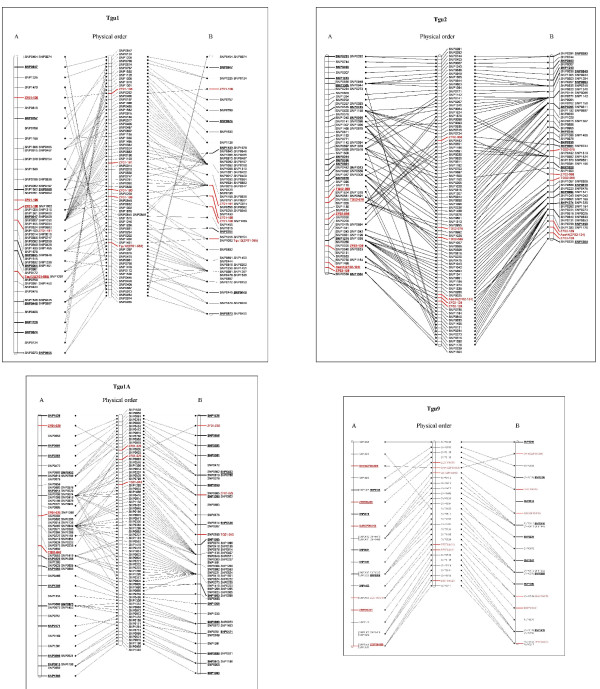
Comparison of two methods of building combined microsatellite and SNP maps. (A) The maps created by the conventional method. (B) Maps created by the method where the SNP markers are mapped before the microsatellites. The maps produced by the 'SNPs preceding microsatellites' are more similar to the physical order of the markers in the genome assembly, which are shown in the centre. The microsatellite markers are highlighted in red and the markers positioned at a LOD ≥ 3 are in bold, underlined font. To aid clarity, the markers on the linkage maps are shown at equidistant positions along the chromosomes, although the total map lengths are shown on the same scale, illustrating the inflated lengths of the conventional build process.